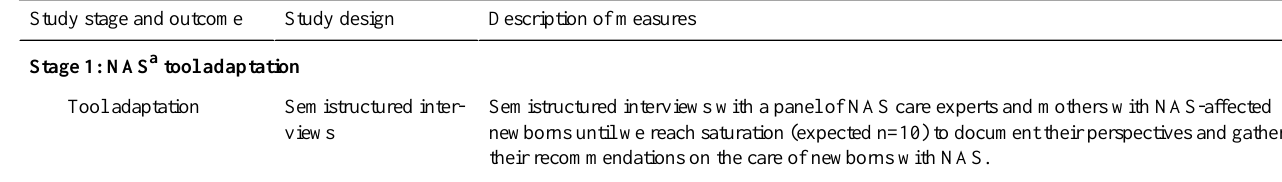
Table 2. Outcomes and description of measures.